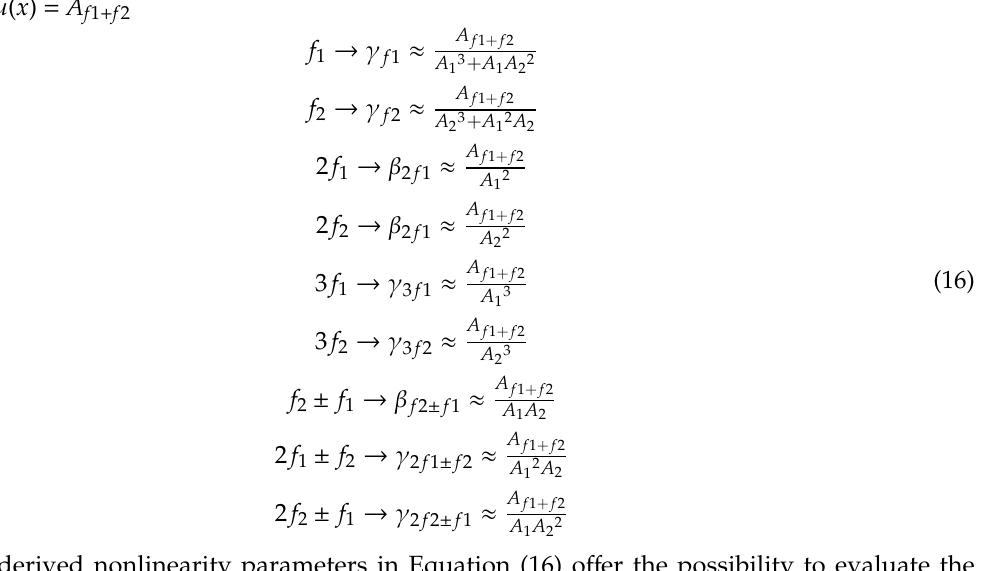
Figure 2. Nonlinearity parameter: ( a ) f 1 = 3 MHz, f 2 = 5 MHz; ( b ) f 1 = 4 MHz, f 2 = 5 MHz. It can be seen that the parameter values measured increase with increasing defect sizes in the samples.